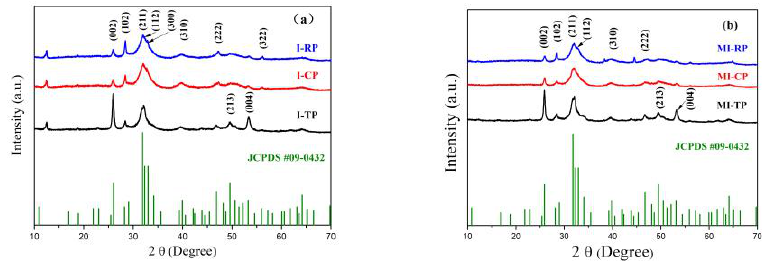
Figure 7. X-ray diffraction patterns: ( a ) ivory with three testing planes, ( b ) mammoth ivory with three testing planes.